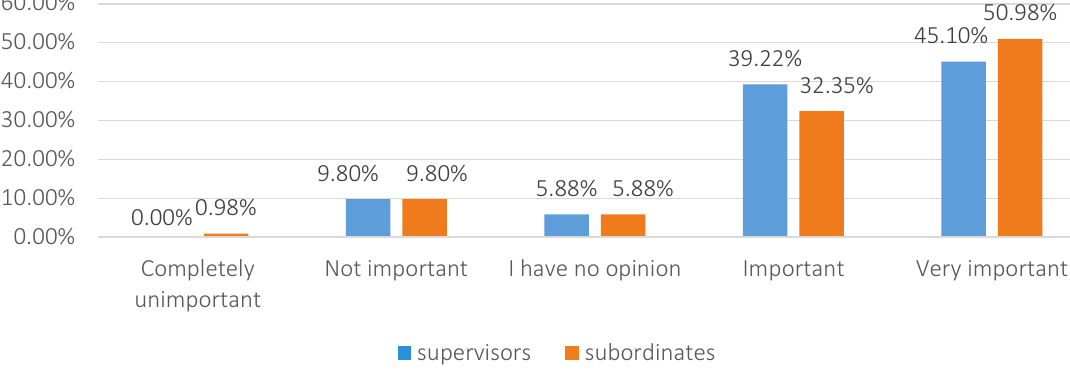
Figure 1. Importance of integrity values in the COVID-19